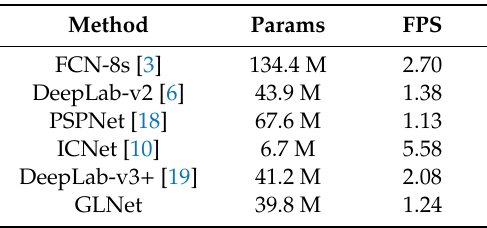
Table 6. Network size and inference speed.